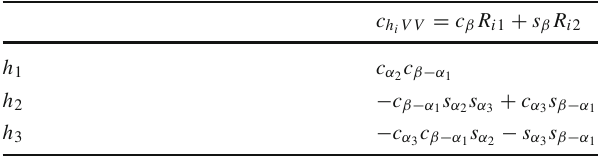
Table 2 The coupling factors of the neutral CP -even Higgs bosons h i to the massive gauge bosons V = W , Z in the